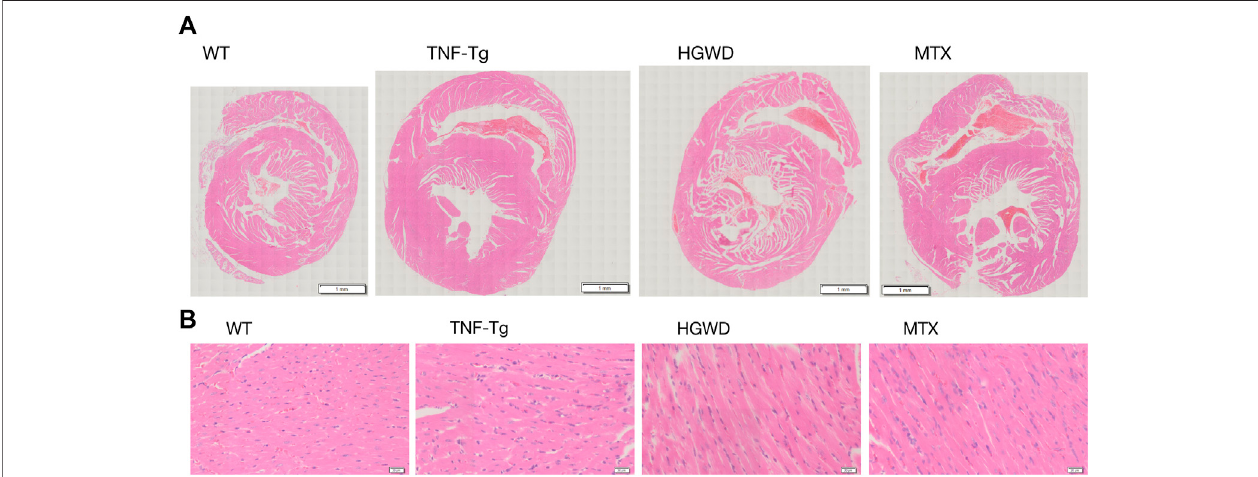
FIGURE 2 | HGWD reduces the in fl ammatory in fi ltration of the heart of TNF-Tg mice. Mouse hearts were taken for HE staining analysis. (A) Representative HE stained sections show that the heart of TNF-Tg mice has obvious in fl ammation in fi ltration, and the arrangement of cardiomyocytes is disordered. The in fl ammatory in fi ltration of the heart of mice treated with HGWD was reduced. (B) Partially enlarged